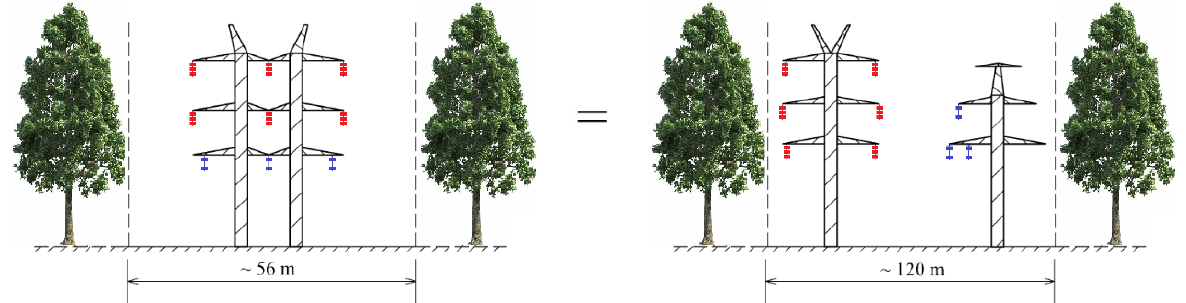
Figure 2. Comparison of the used technological belt for a multi-circuit, multi-voltage overhead line (three-circuit double-voltage line 2 × 400 kV) using the basic solution.